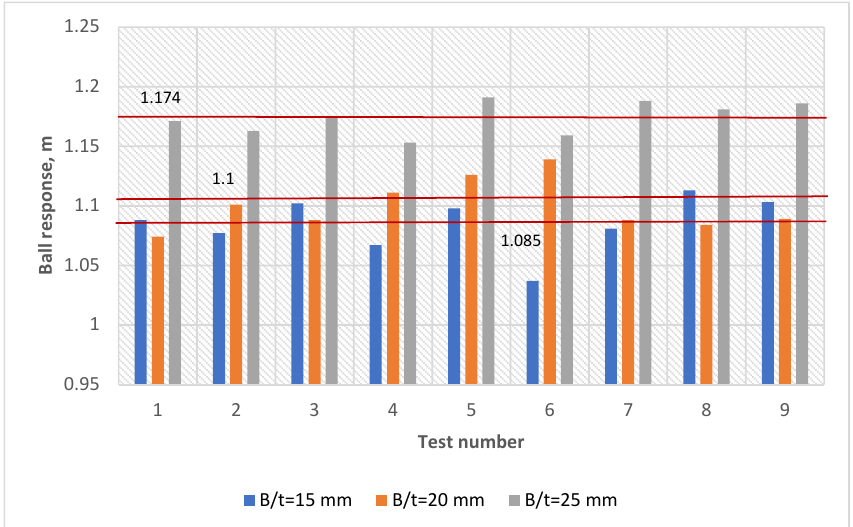
Figure 10. Basketball ball response on type B panels and different thicknesses of parquet friezes.